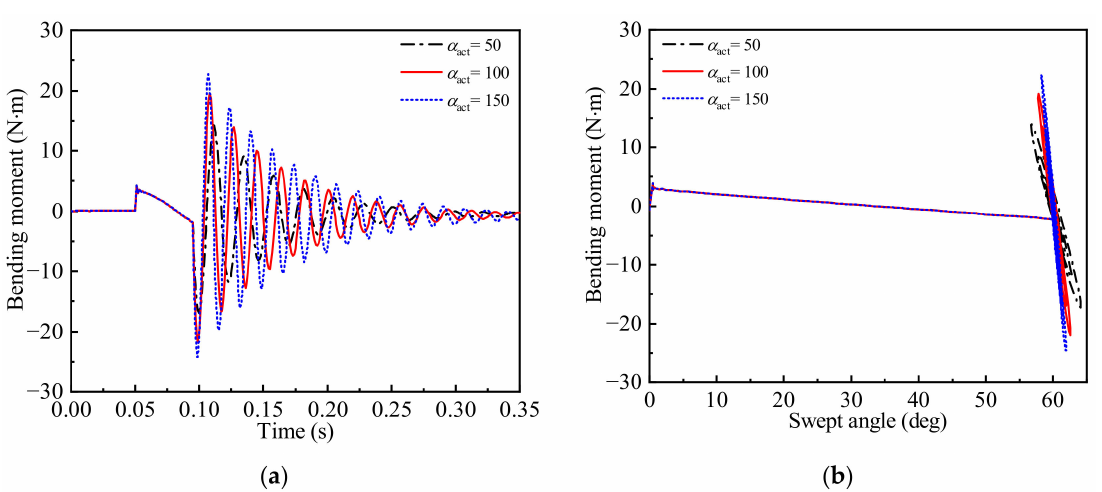
Figure 23. Transient responses of the wing-root bending moment. ( a ) Bending moment vs. time. ( b ) Bending moment vs. sweep